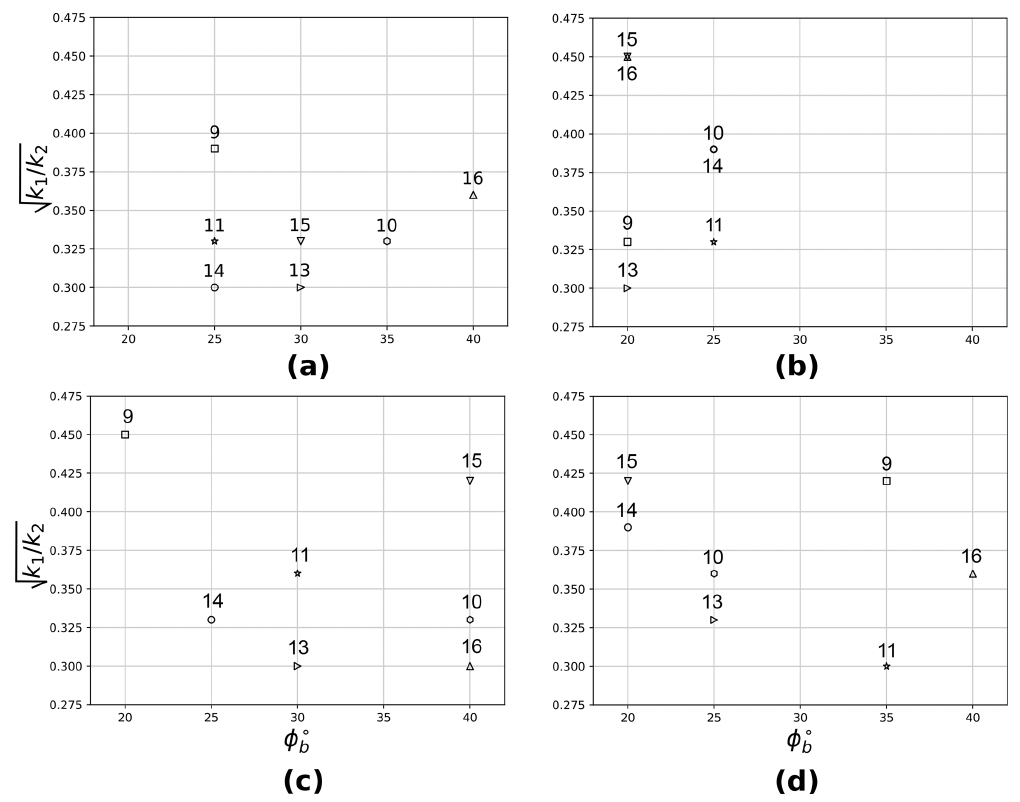
√ k 1 /k 2 and φ b ) for each of the selected experimental tests based on all three parameters (a) , Figure A1. The best-fitting set of parameters ( only the flow maximum height (b) , only the mean front velocity (c) and only the maximum impact pressure (d)